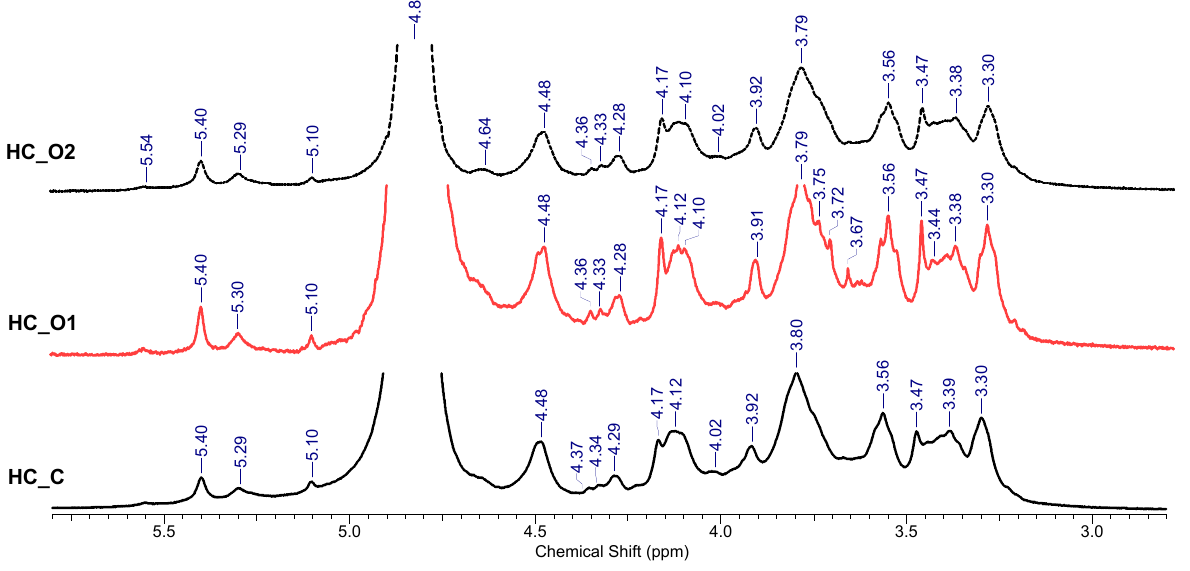
Figure 7. 1 H-NMR spectra of hemicelluloses separated from wheat straw.